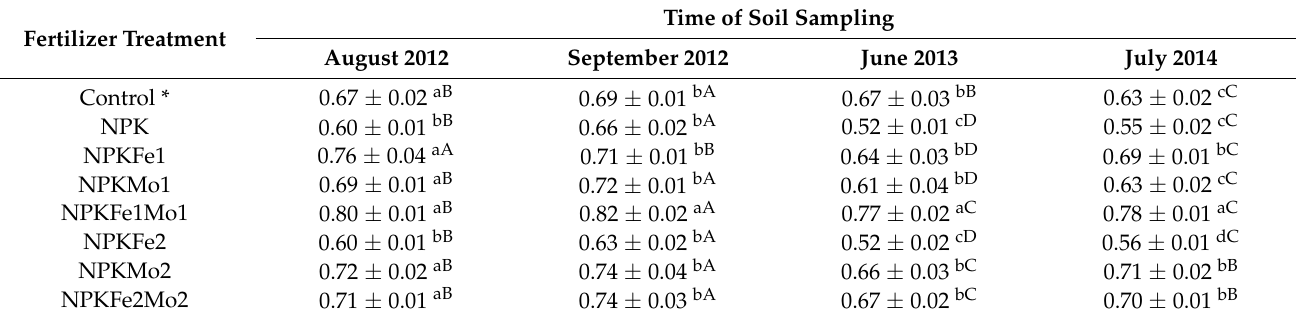
Table 6. Alkaline phosphatase activity in soil (in mmol PNP h − 1 kg − 1